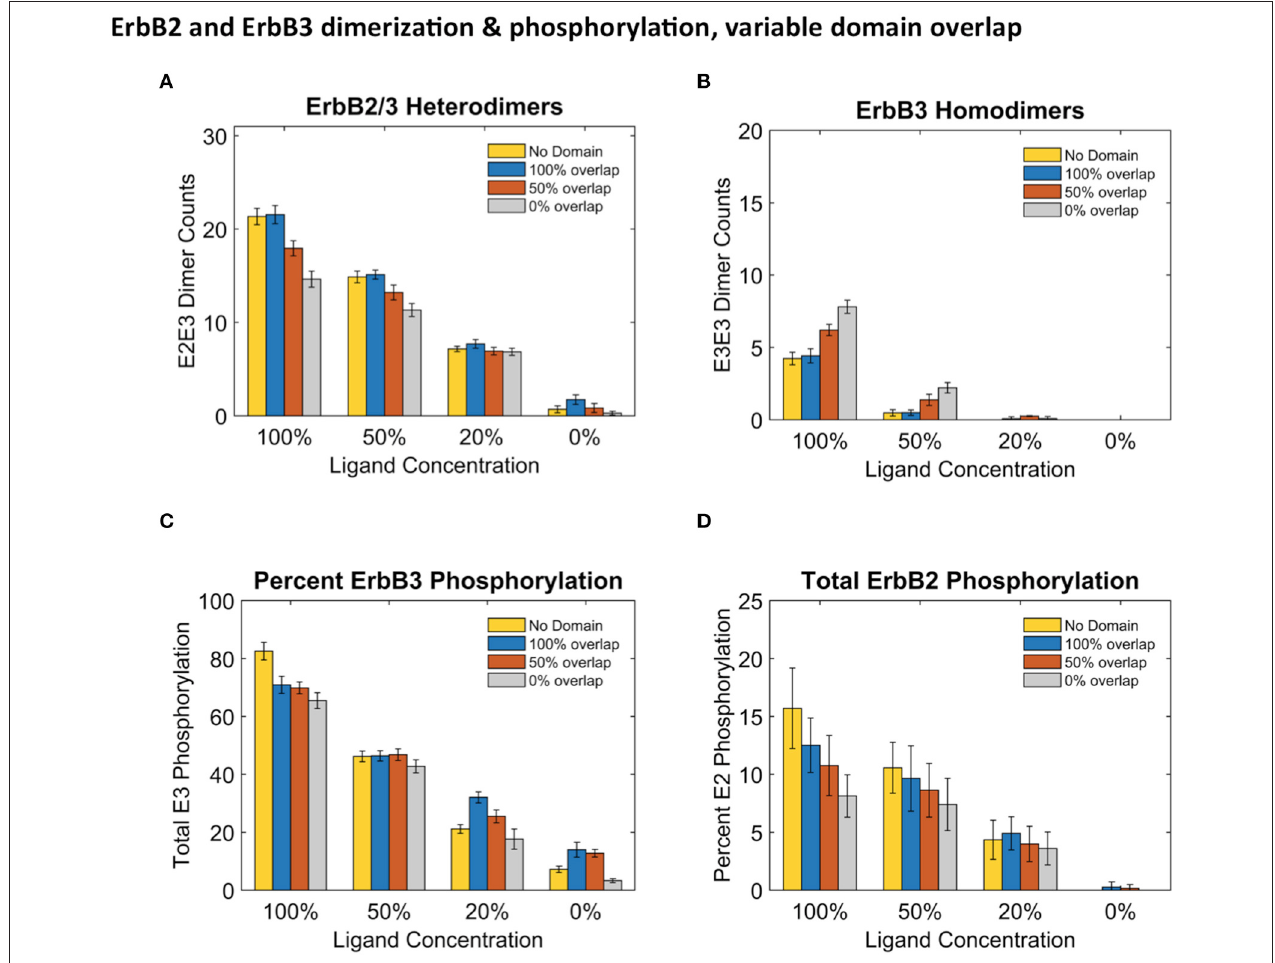
FIGURE 4 | Overlapping domains influence dimer formation and phosphorylation. (A,B): Dimer counts across different ligand concentrations with 4 different membrane configurations- 100% (blue bars), 50% (orange bars), and 0% overlap (gray bars) as well as no domain simulations (yellow bars) for ErbB2/ErbB3 heterodimers (A) and ErbB3 homodimers (B) . (C,D): Total receptor phosphorylation across different ligand concentrations and all four domain configurations for ErbB3 (C) And ErbB2 (D) . All bars are the averages of 4 runs ± standard